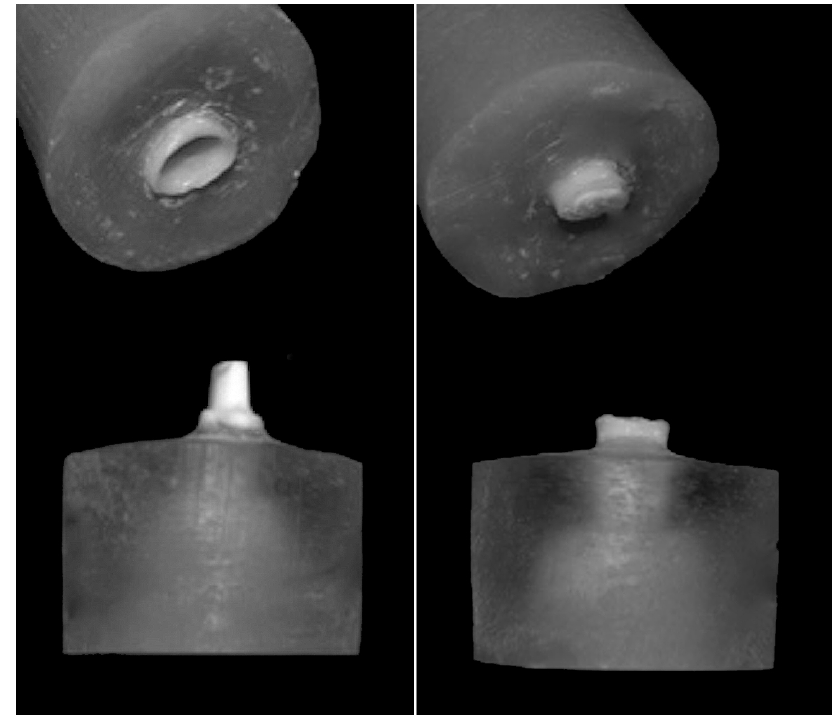
Figure 4. Examples of different failure modes: decementation ( left ) and fracture ( right